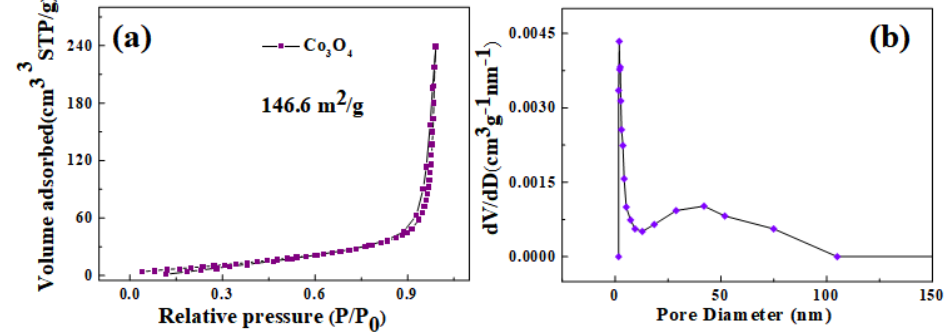
Figure 3. ( a ) Nitrogen adsorption-desorption isothermal curve. ( b ) Pore size distribution of Co 3 O 4 nanosheets.